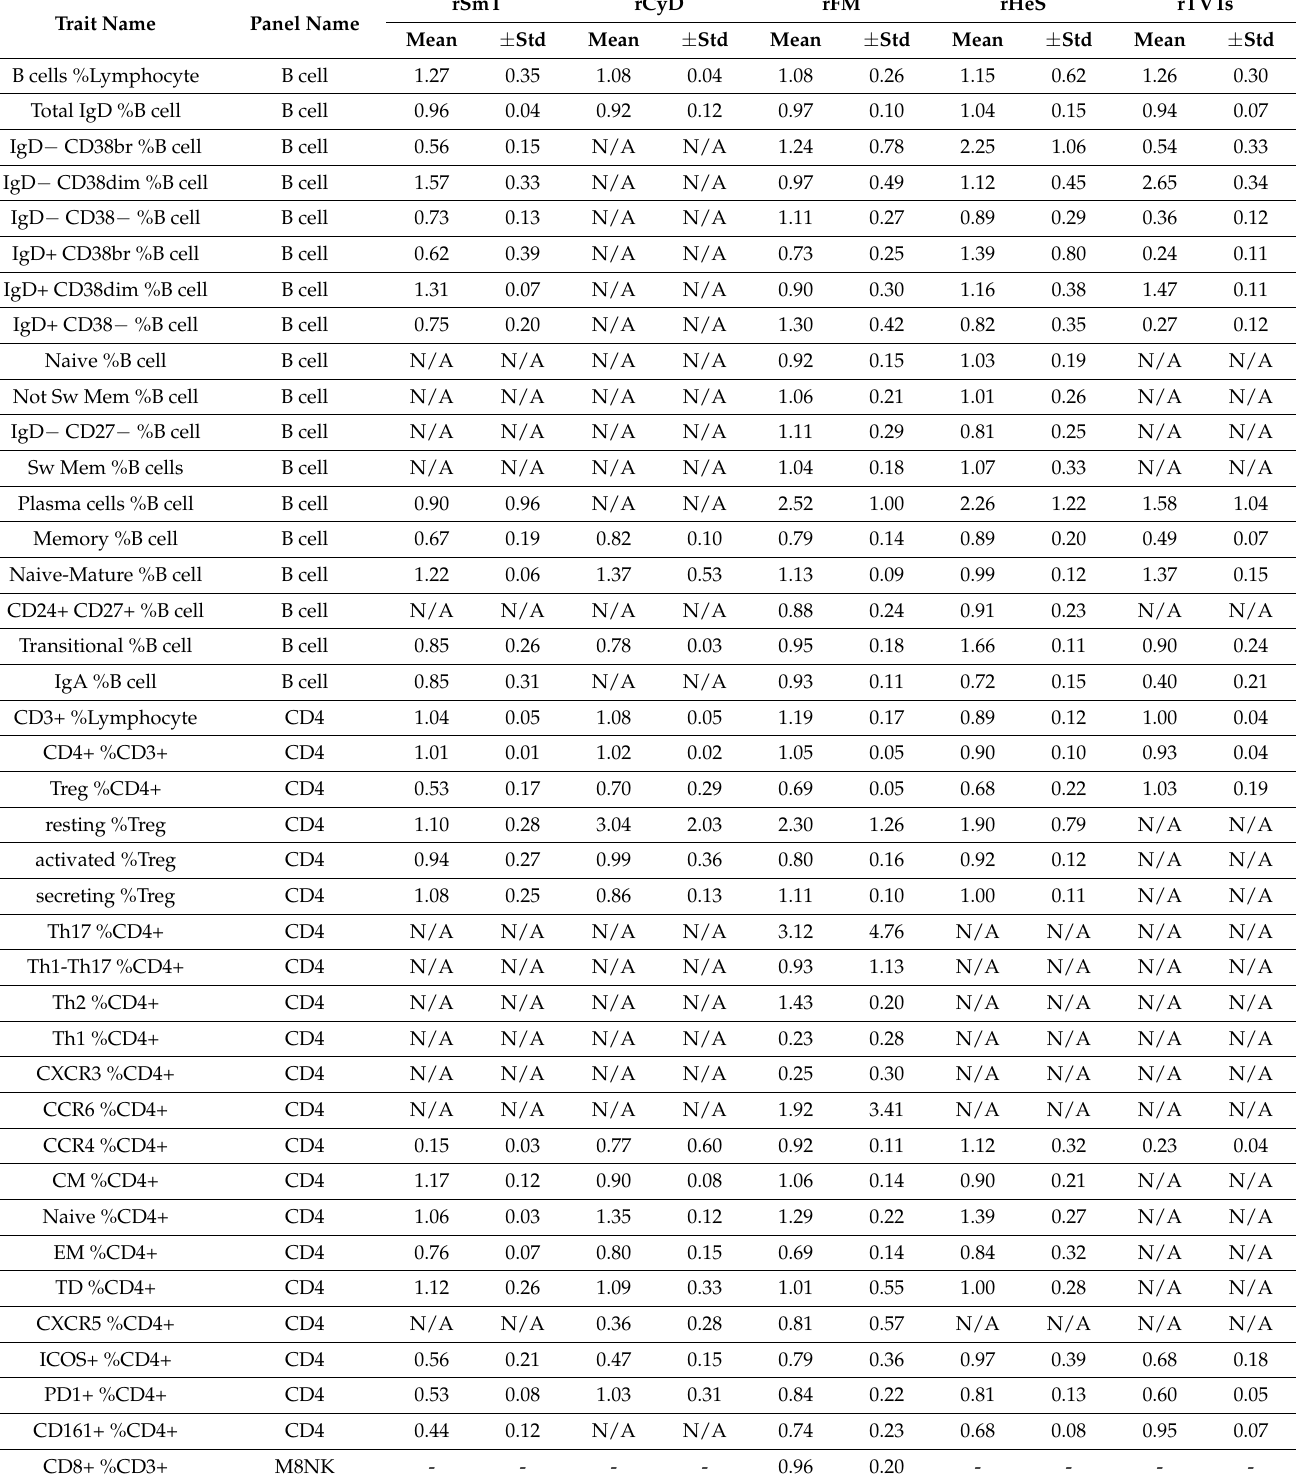
Table 2. Thawed/fresh frequency ratios of the immune cells assessed. From left to right are indicated: the cell-type measured; the panel name (Vi = viability panel); the mean; and the standard deviation ( ± StD) of T/F ratios (r) for the five methods used. (N/A= not